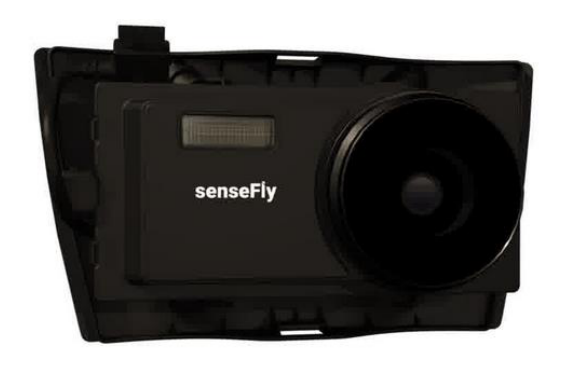
Figure5. SenseFly Aeria X